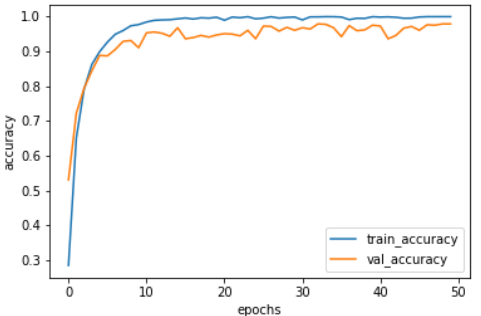
Figure 7. The accuracy curves of the training and validation for EV 5_2 .